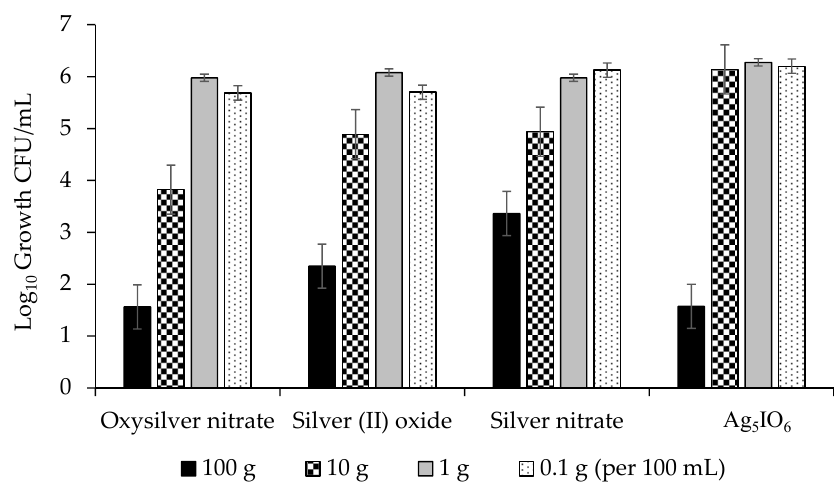
Figure 5. E ff ects of four silver-based seed coatings on the lg growth (CFU / mL) of Pseudomonas syringae Figure 5. Effects of four silver-based seed coatings on the lg growth (CFU/mL) of Pseudomonas syringae pv. syringae . Molecules 2019 , 24 , x FOR PEER REVIEW pv. syringae .